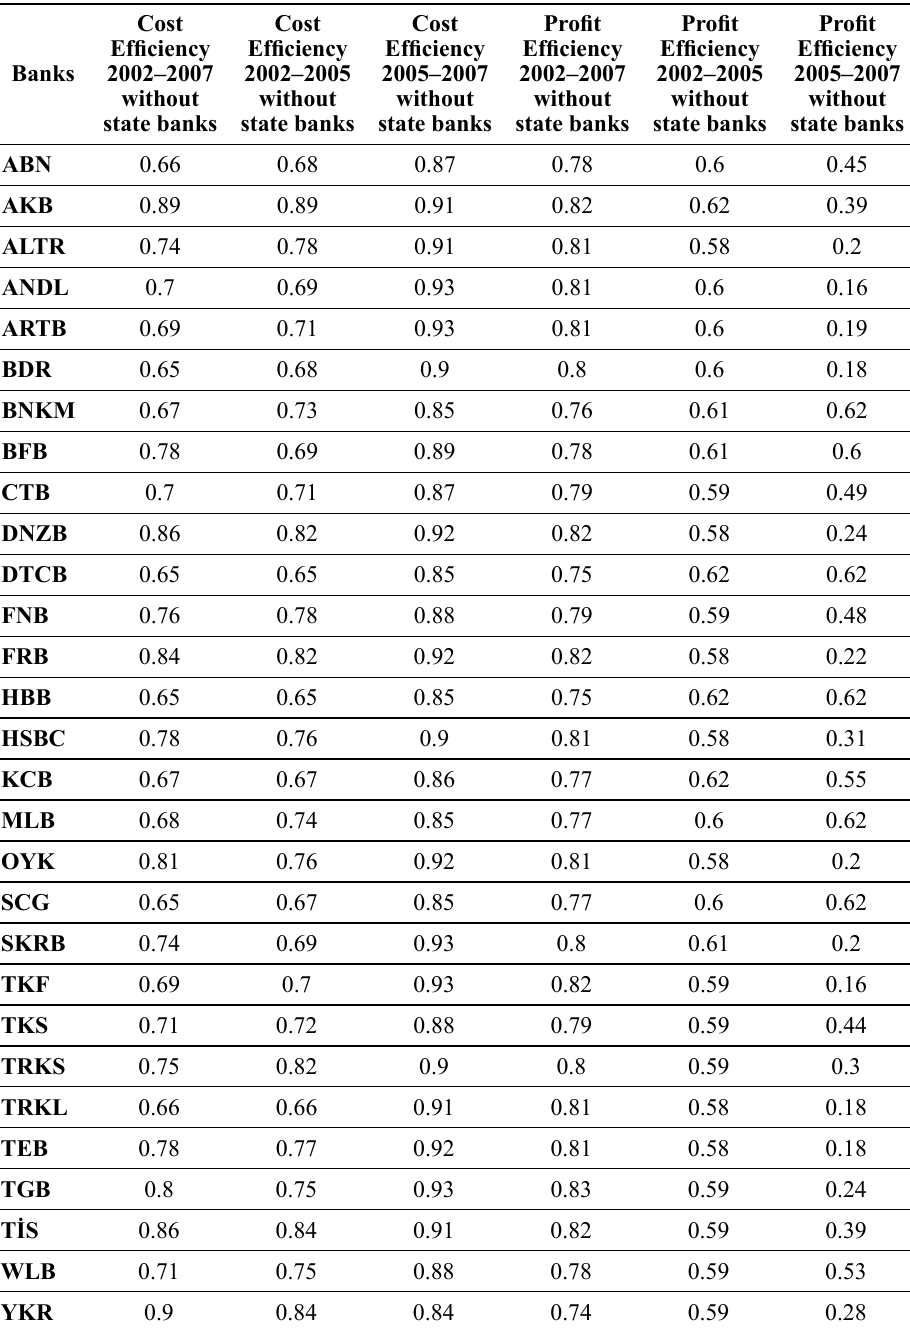
Table A.6. Efficiency Scores of the Banks Excluding State Banks